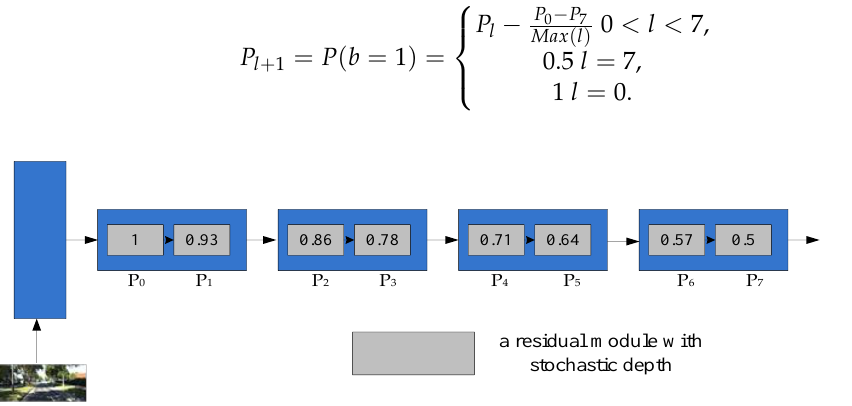
Figure 7. The probability of dropping hidden nodes.